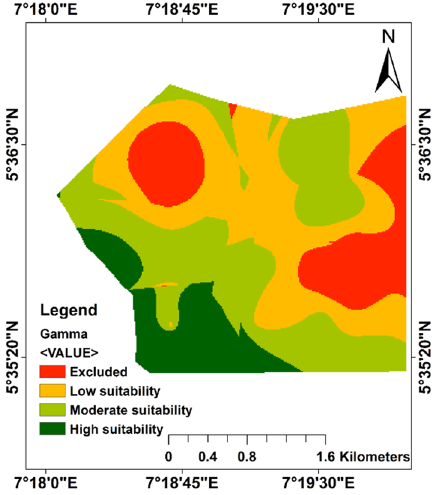
Fig. 6 Site suitability map using fuzzy gamma overlay